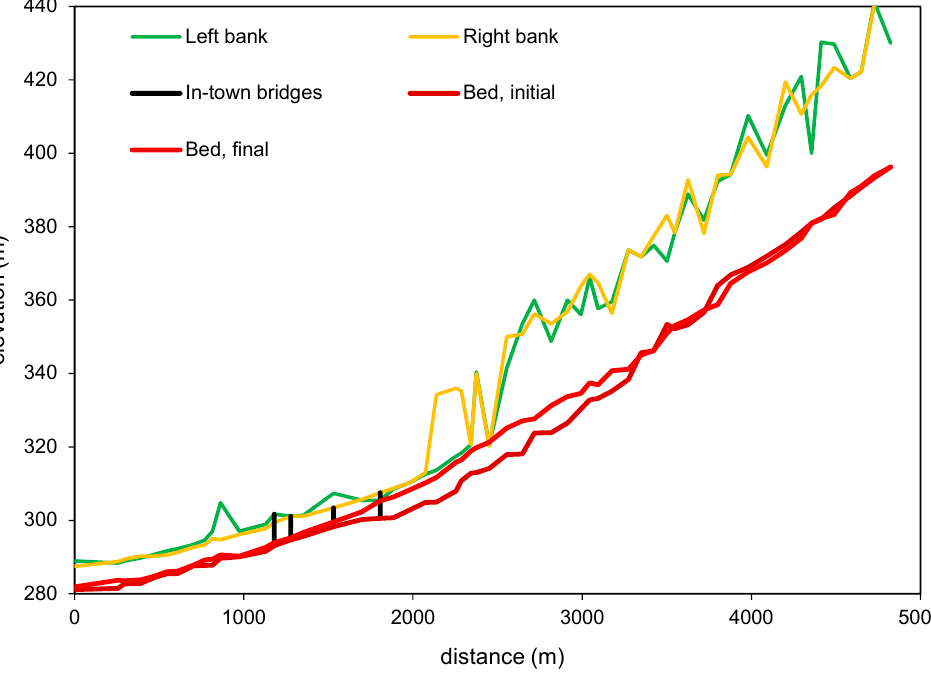
Figure 11. Result of the numerical model of the 1987 flood event comparing the river profile at the beginning and at the end of the simulation.